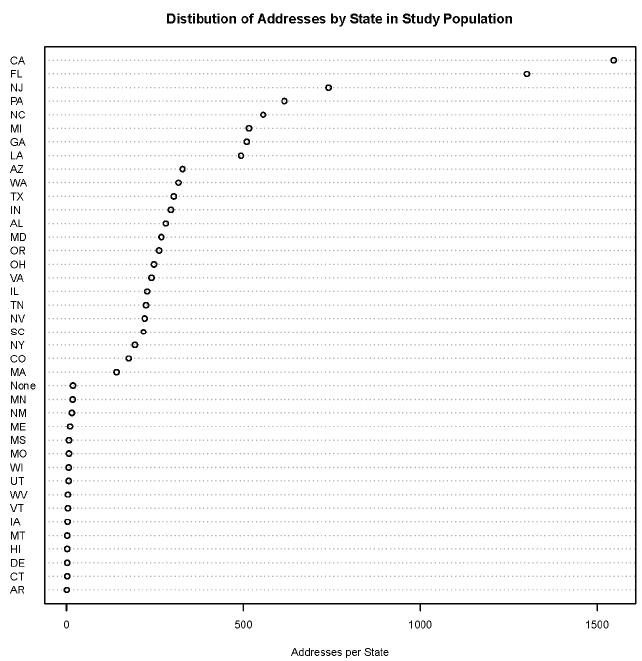
Figure 1. Distribution of study population addresses by